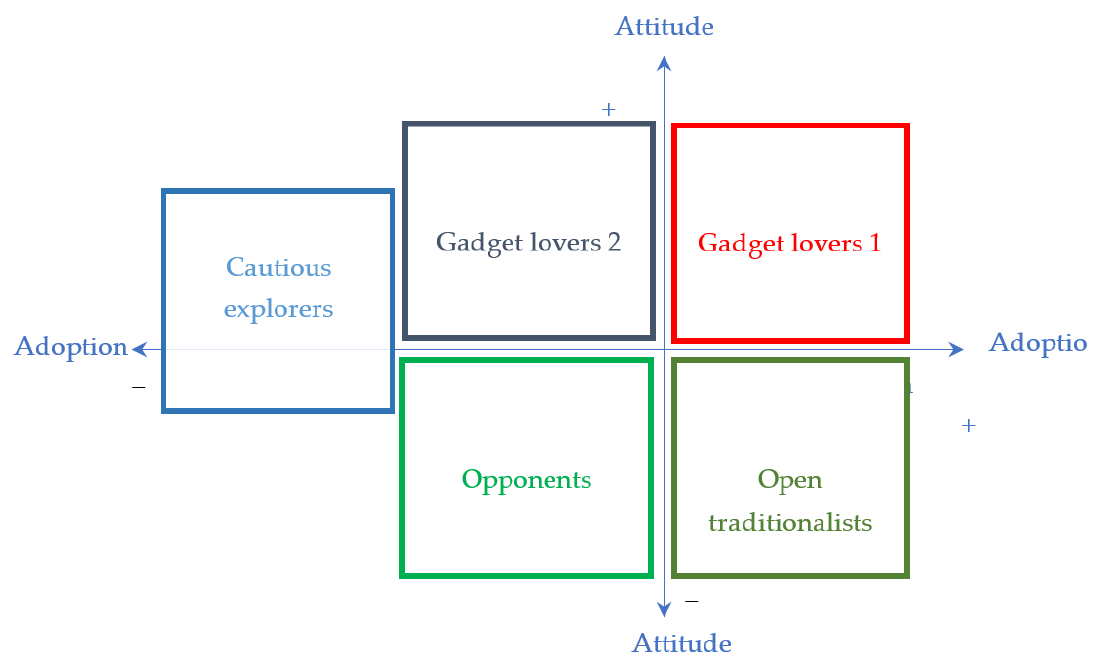
Figure 2. Types of e-bike users and non-users. Source: own elaboration on the basis of the questionnaire survey.